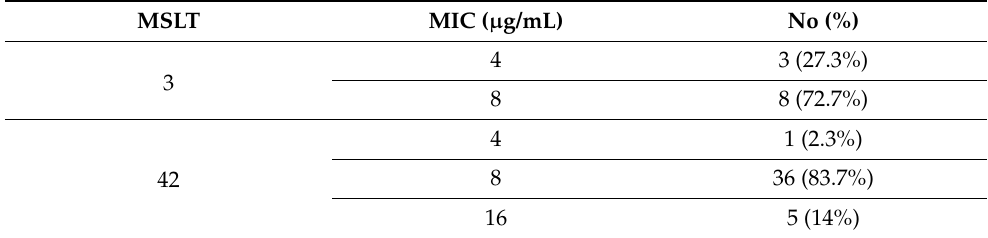
Table 3. Distribution of fusidic acid MICs among 53 S. haemolyticus fusidic acid resistant isolates. MSLT MIC ( µ g/mL) No